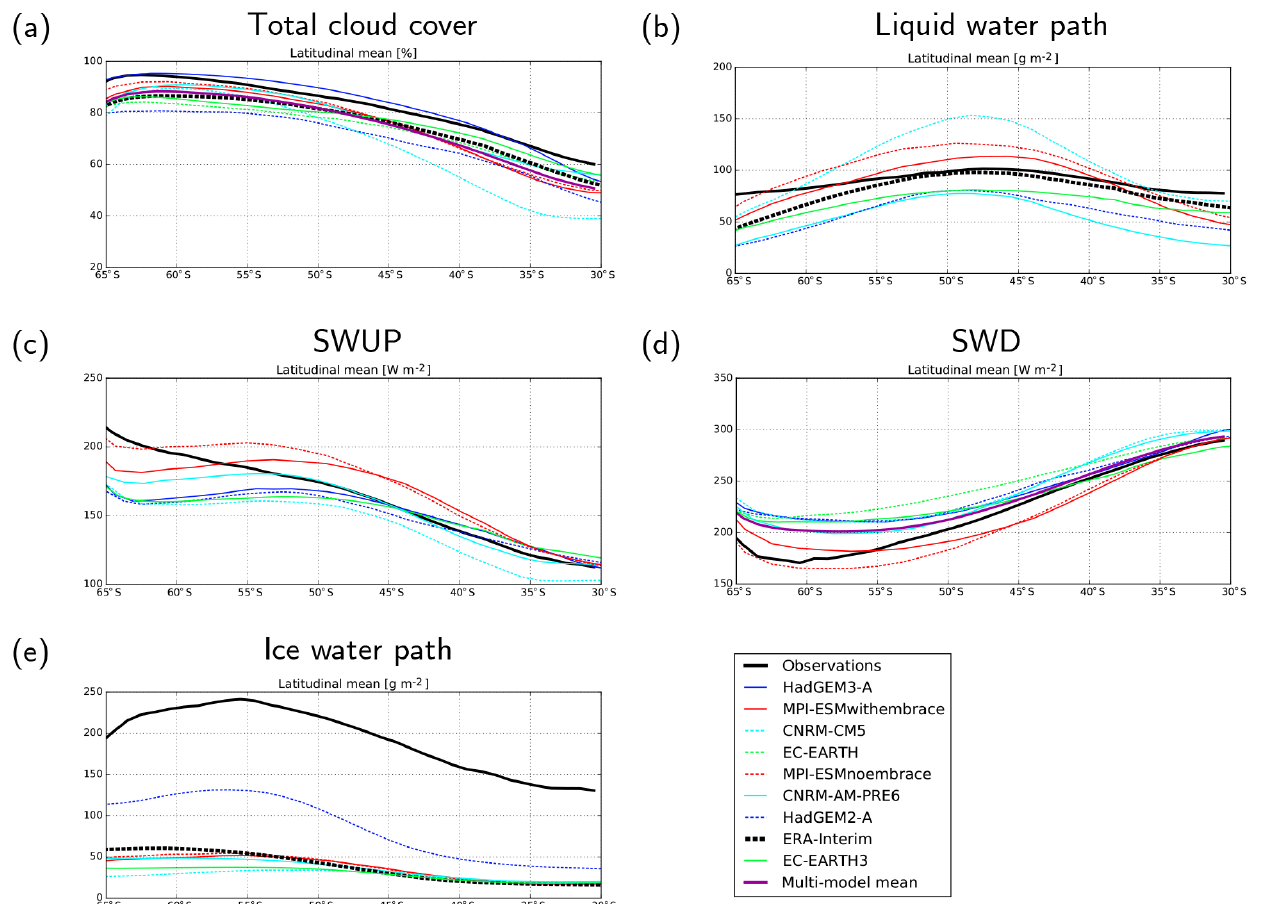
Figure 16. Latitude cross section of DJF zonal mean (a) total cloud cover, (b) liquid water path, (c) TOA outgoing shortwave radia- tion (SWUP), (d) surface downwelling shortwave radiation (SWD), and (e) ice water path. Shown are the CMIP5 and EMBRACE